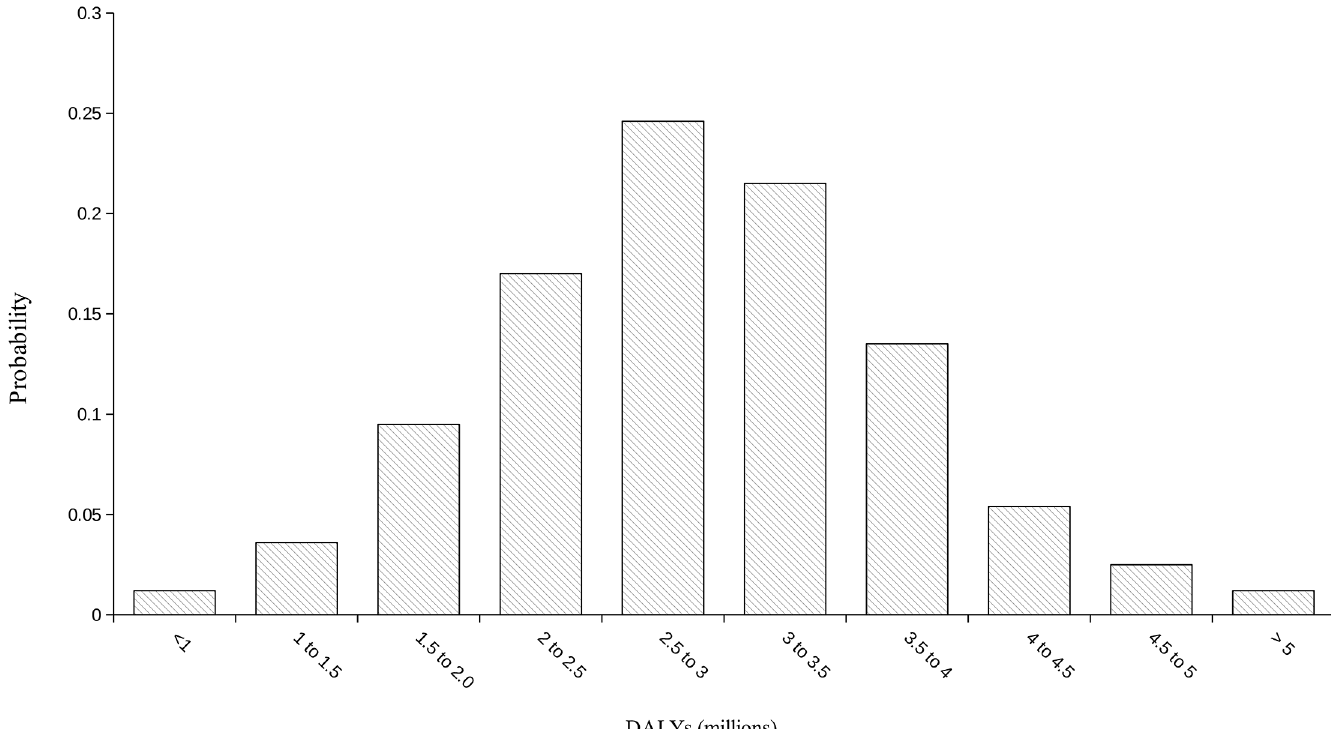
Fig 2. Frequency distribution of the global burden of